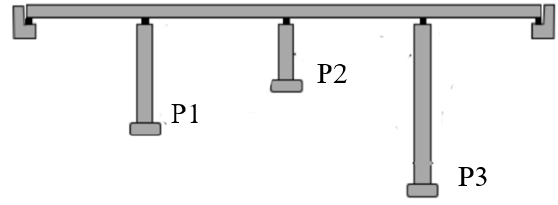
Figure 5. Bridge structural model.